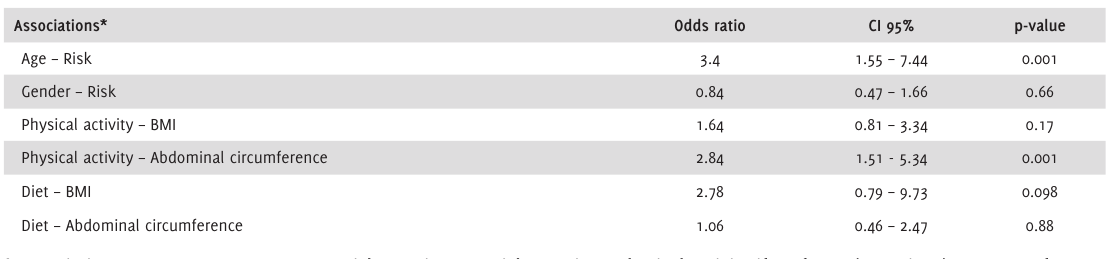
Table 1. Values of statistical association measures found for related variables in physicians.